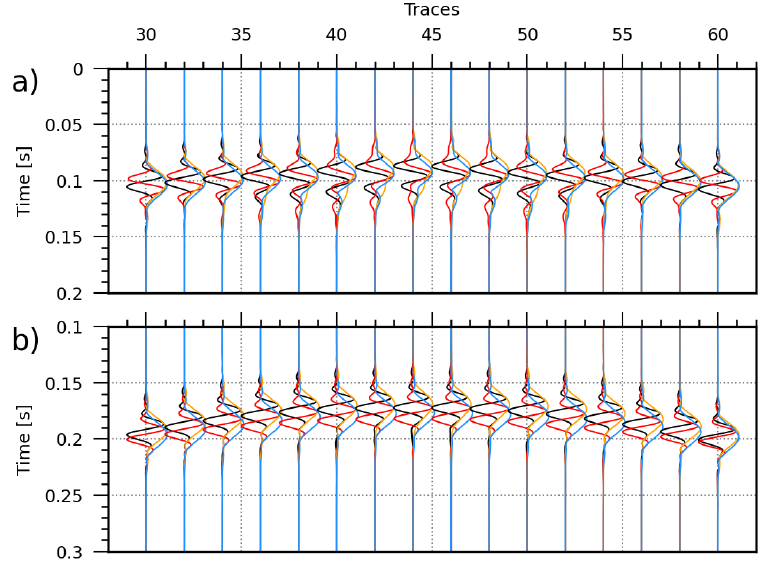
Figure 4. ( a ) Comparison of the traces (vertical component) of observed P-waves (black lines) and synthetic P-waves with the wrong source wavelet (red lines); The yellow and blue lines indicate their envelopes, respectively. ( b ) Comparison of the traces (vertical component) of observed S-waves (black lines) and synthetic S-waves with the wrong source wavelet (red lines); The yellow and blue lines are their envelopes.